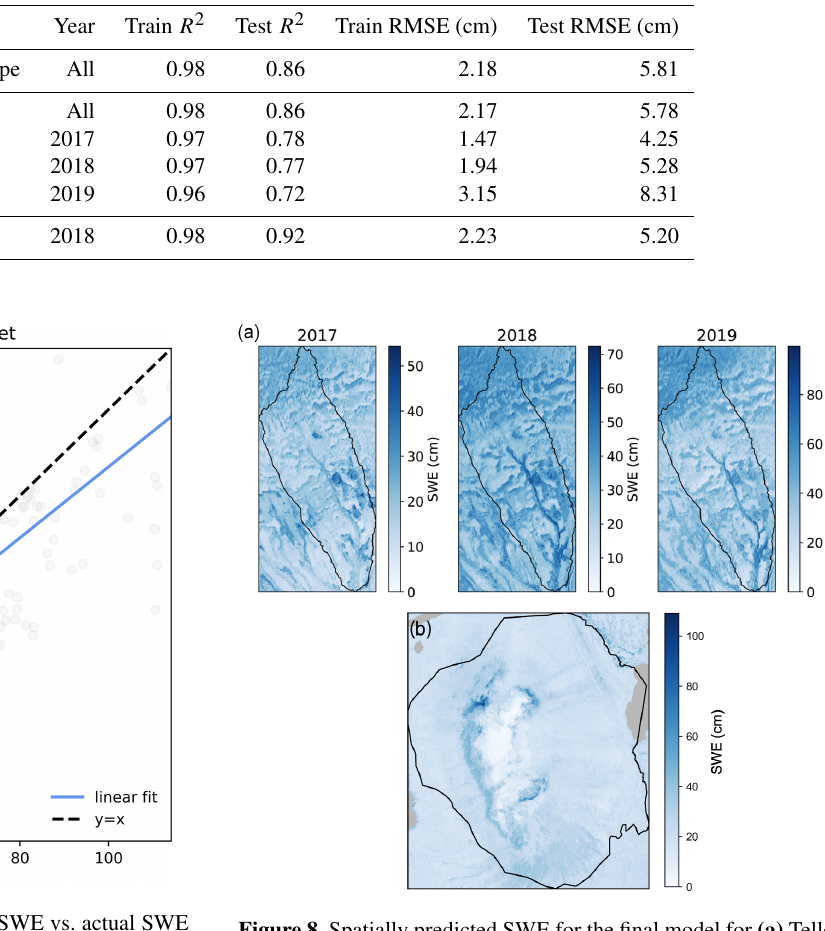
Figure 8. Spatially predicted SWE for the final model for (a) Teller in 2017, 2018, and 2019 and (b) Kougarok Hillslope in 2018. The gray areas in the Kougarok Hillslope map are small lakes. Note that the scales change for each year and study location across the